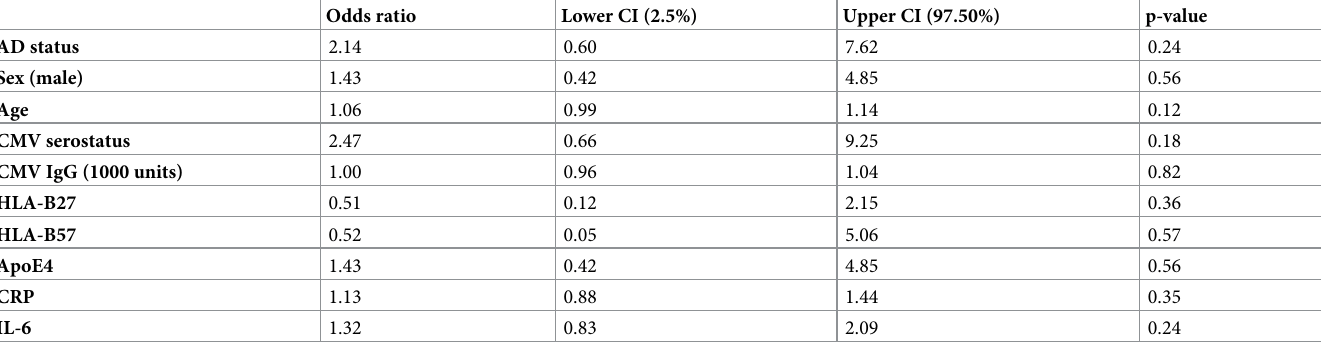
Table 2. Univariable logistic regression analysis of TTV status predictors. All subjects included in analysis. Odds ratio Lower CI (2.5%) Upper CI